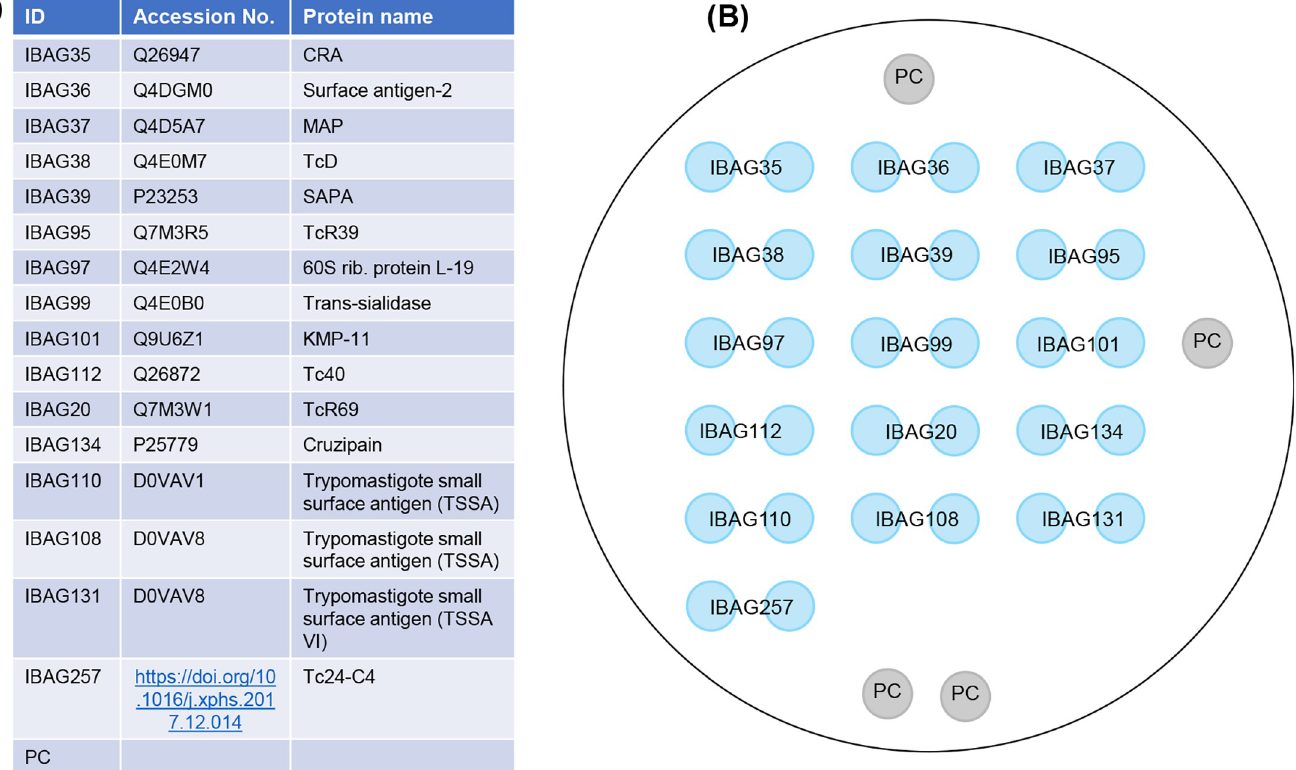
Fig 1. Antigens used in multiplex Chagas assay. (A) List of antigens. (B) Arrangement of antigens spotted in duplicate into the wells of 96-well microtiter plates. Four Positive Control (PC) spots (Methods) were printed to validate the test and give the spatial orientation of the matrix.